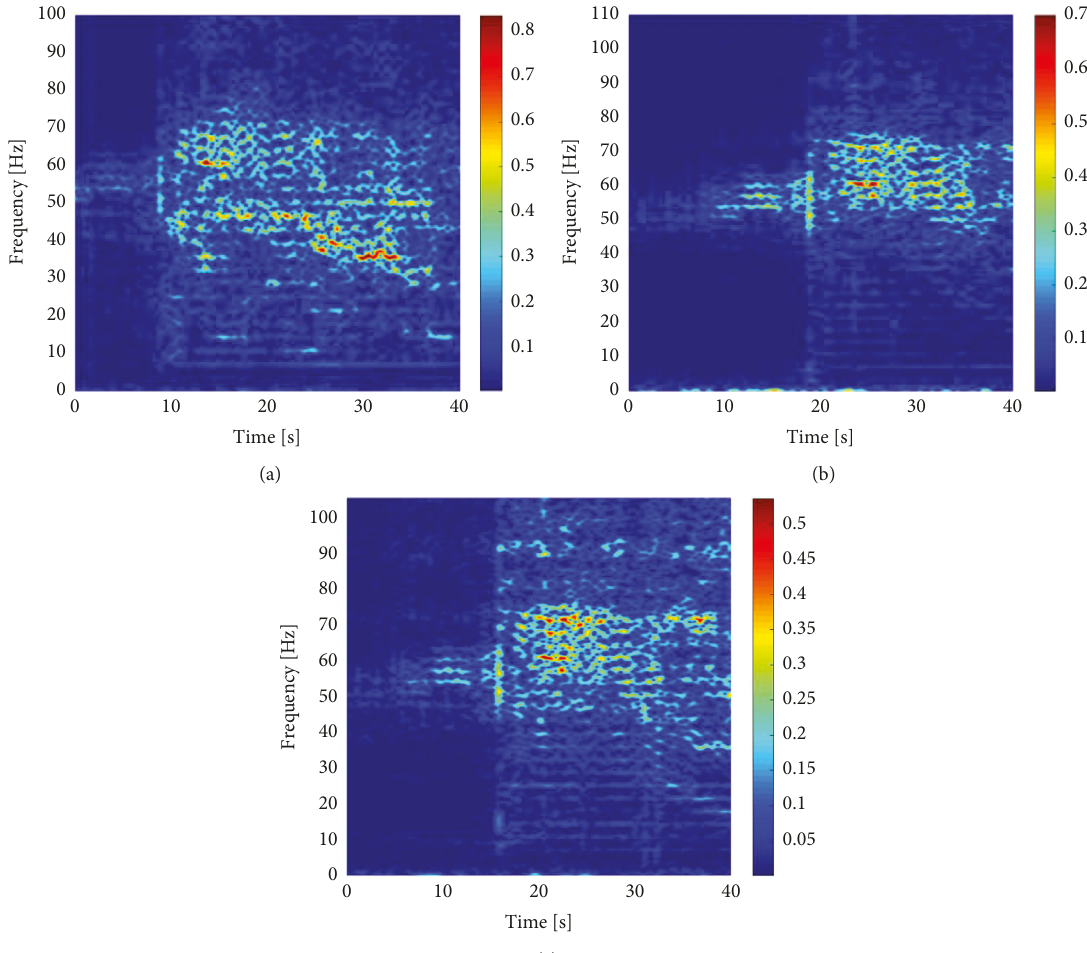
Figure 8: Results of time-frequency analysis. (a) X -direction (b) Y -direction. (c) Z